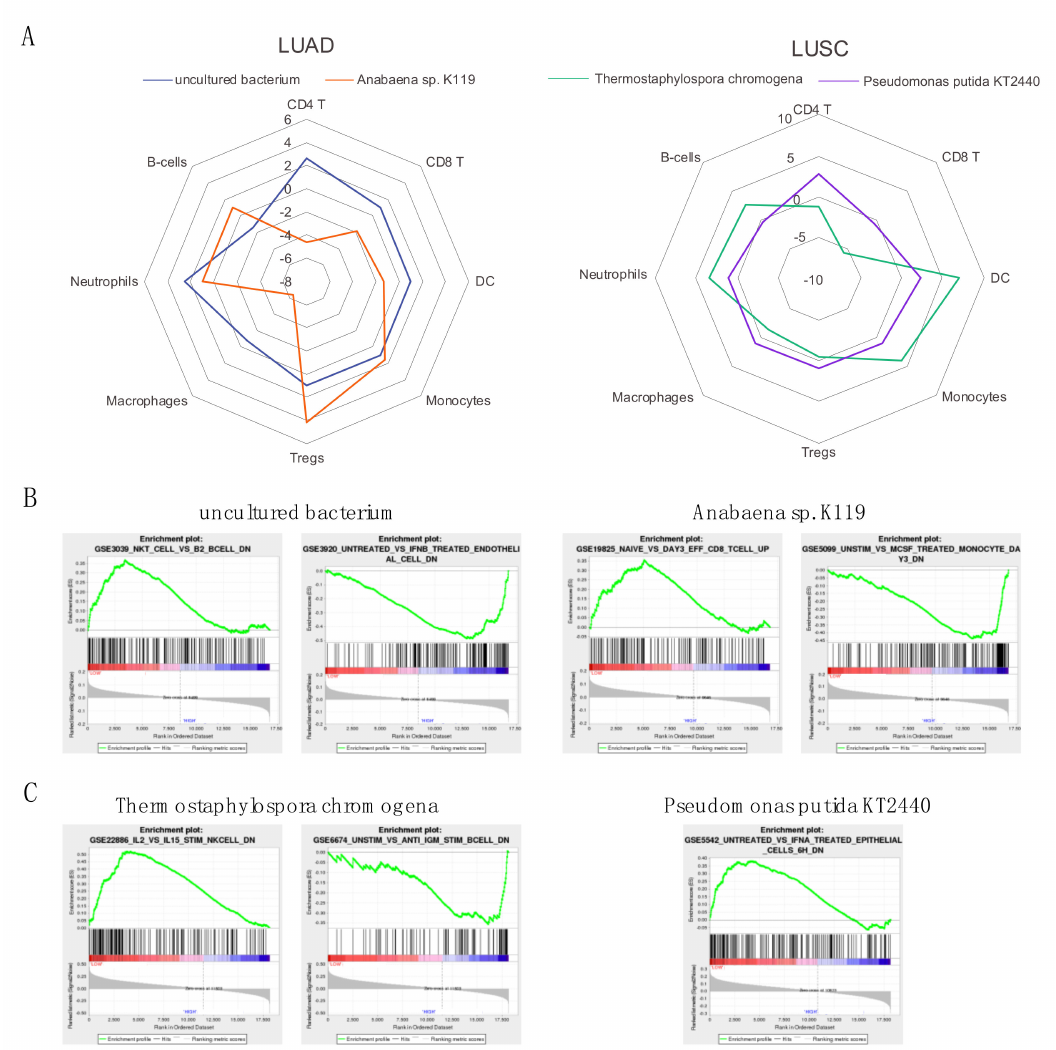
Figure 6. Association between di ff erentially abundant microbes in LUAD and LUSC and immune signatures. Only the two most di ff erentially abundant microbes in each cancer are included (Kruskal–Wallis test, p < 0.05). ( A ) Radar plot demonstrating the sum of the -log( p -value) or log( p -value) of immune and cancer pathways that have positive and negative correlations, respectively, with microbe abundance and are associated with the immune cell types depicted. ( B ) Select GSEA plots of immunologic signatures for the two most significant microbes in LUAD and ( C ) LUSC (Kruskal–Wallis test, p < 0.05). A peak indicates that a higher abundance of the microbe correlates with a higher expression of the genes in the gene set whereas a valley indicates that lower abundance of the microbe correlates to lower expression of the genes in the gene